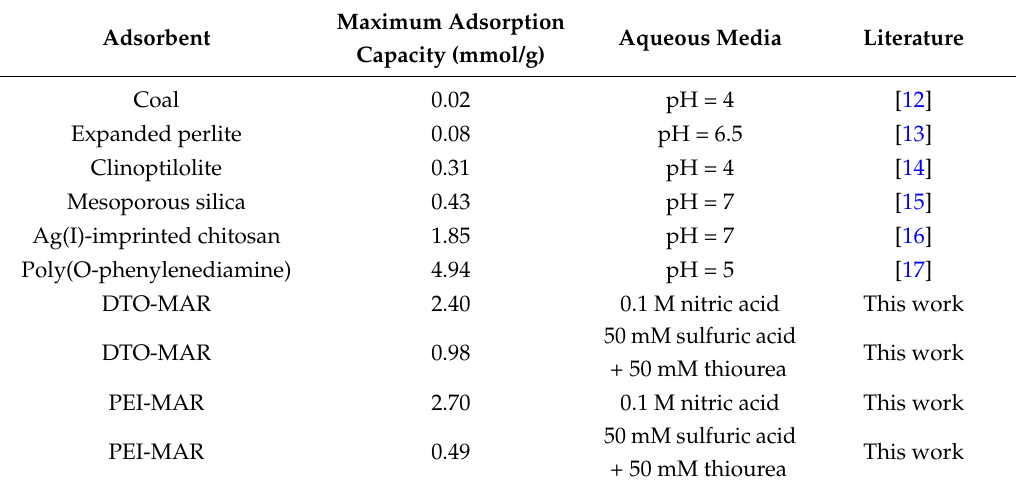
Figure 8. Adsorption isotherms of Ag(I) on DTO ‐ MAR from: ( a ) 0.1 M nitric acid, and ( b ) a mixture of 50 mM sulfuric acid and 50 mM thiourea. Conditions: weight of adsorbent = 10 mg, volume of test solution = 10 mL, temperature = 30 °C, and shaking time = 4 days. Table 1 . Comparison of maximum adsorption capacity of various adsorbents for silver(I).